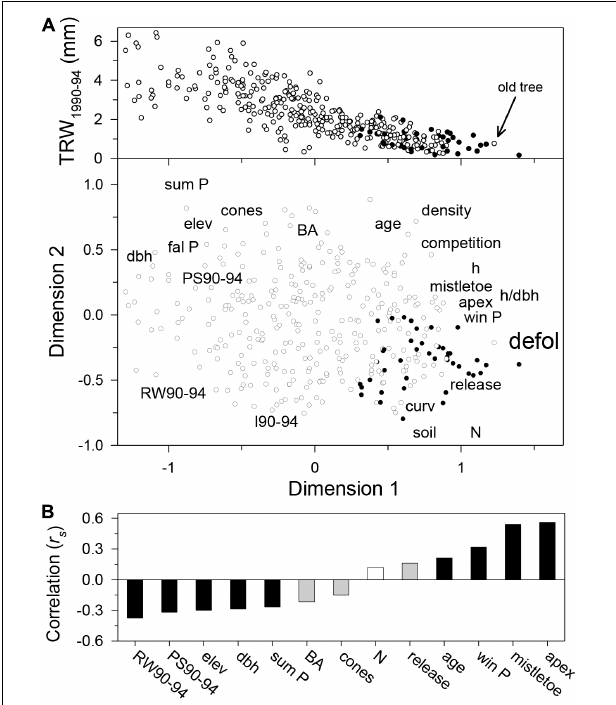
FIGURE 3 | Main variables based on tree-level data which are related to forest decline as displayed in the ordination diagram based on the first two NMDS dimensions (A) and the ranking of those most highly related with crown defoliation (B) . The lower graphs shows the Spearman correlation ( r s ) of tree variables and defoliation ( n = 360 trees; white bar, non-significant correlation; gray bars, p < 0.05; black bars, p < 0.01). The uppermost scatter plot shows the relationship between the first NMDS axis scores and mean tree-ring width for the 1990–1994 period (note the low growth of an old but undefoliated tree indicated with the arrow). Trees are represented according to their crown defoliation (filled symbols, crown > 50% defoliation; empty symbols, crown ≤ 50% defoliation). The variables scores have been displaced to improve clarity. Variables and their abbreviations are as follows: age, estimated tree age at 1.3 m; apex, presence of abnormal growth features in the crown apex; BA, basal area in the neighborhood of each sampled tree; competition, Lorimer competition index; curv, terrain curvature; cones, cone production; dbh, stem diameter at 1.3 m; defol, crown defoliation; density, tree density; elev, elevation; mistletoe, mistletoe abundance; fal/sum/win P, percentage of total annual precipitation recorded during fall/summer/winter; h, height; h/dbh, height-to-dbh ratio; RW90-94/I90-94/, mean tree-ring width/index for the 1990–1994 period; N, northness; PS90-94, summer precipitation recorded